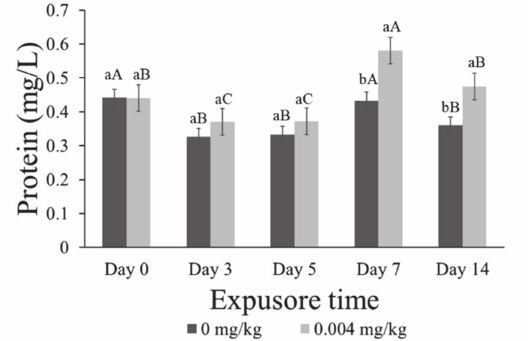
Figure 9. Amount of protein (mg/L) in Eisenia fetida exposed to endosulfan lactone in solid substrate at 0, 3, 5, 7, and 14 days. Lowercase letters indicate the statistically significant difference ( p < 0.05) for each day of exposure and uppercase letters indicate the statistically significant difference ( p < 0.05) between concentrations.